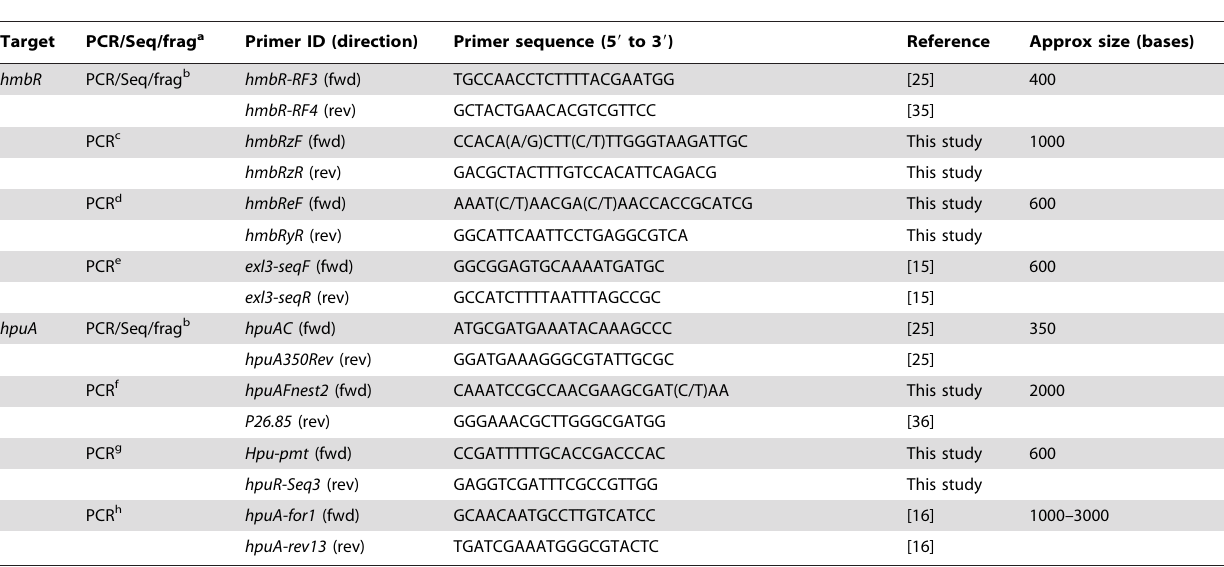
Table 2. Primers used for PCR and sequence and fragment analyses for hmbR and hpuA